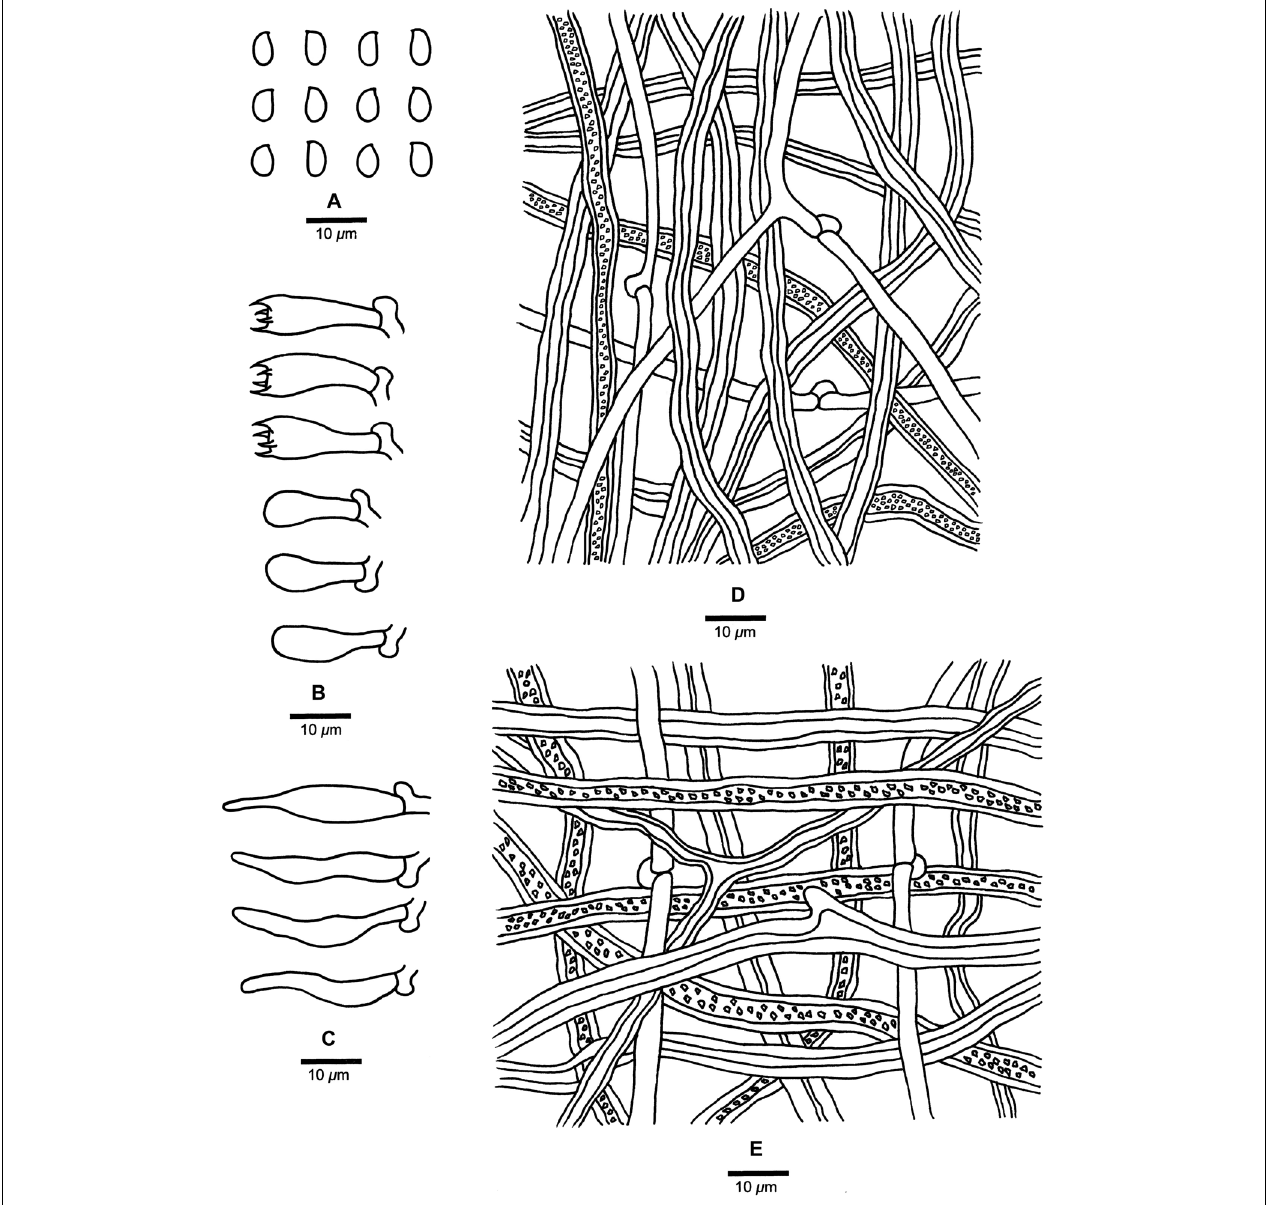
FIGURE 6 | Microscopic structures of Fomitopsis kesiyae (drawn from the holotype). (A) Basidiospores; (B) Basidia and basidioles; (C) Cystidioles; (D) Hyphae from trama; (E) Hyphae from context. Bars: A–E = 10 µ m.